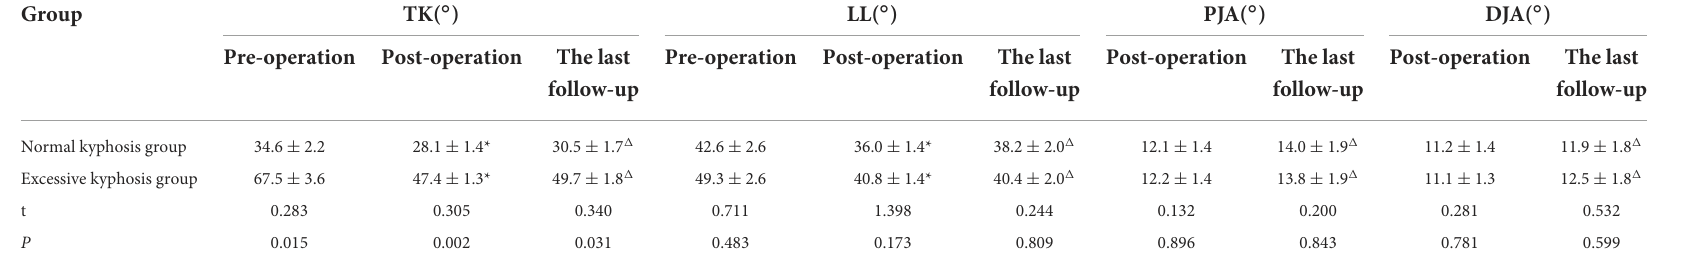
TABLE 3 Comparison of sagittal plane indexes on X-ray radiograph of the entire spine in standing position between the two groups ( ¯ x ± s). Group Pre-operation Post-operation Post-operation The last follow-up follow-up follow-up